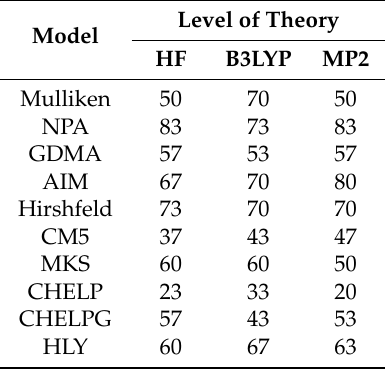
Table 3. Percentage similarity of the conformer sequences predicted by ∆ E elst to the reference sequences determined using ∆ E . The values of ∆ E elst are calculated by 10 partial atomic charge models operating on the wave functions/electron densities calculated at three levels of